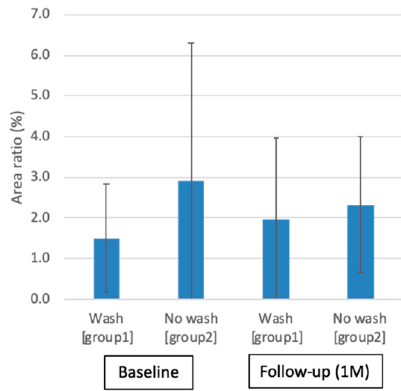
Figure 5. Ratio of areas stained with MUC16 antibodies to overall area of cellular pick-up. Note the nonsignificant MUC16 antibody staining changes between before and after 1 month of eyewash use ( p > 0.05).